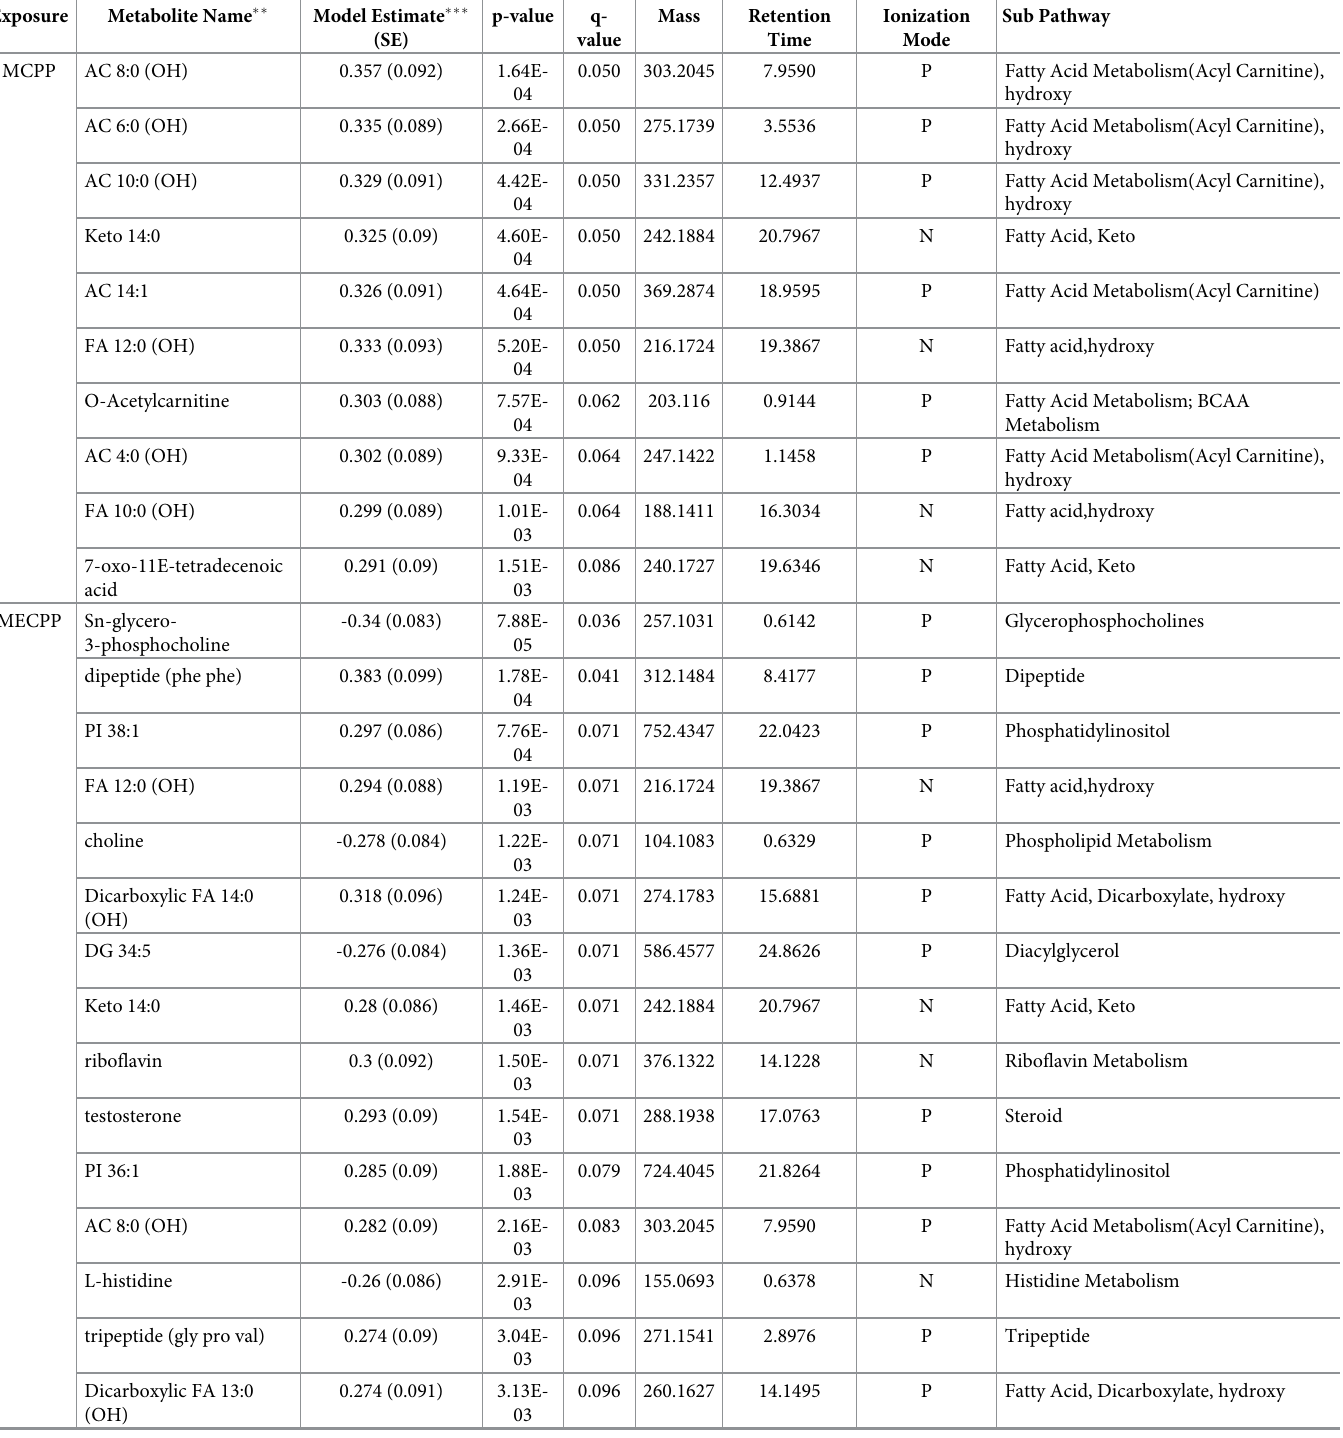
Table 3. Significant associations (q < 0.1) between maternal phthalate exposures during third trimester and metabolites among 124 girls.